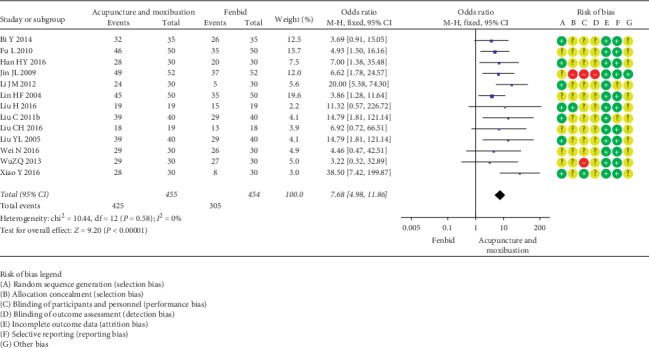
Acupuncture and moxibustion vs. Fenbid.